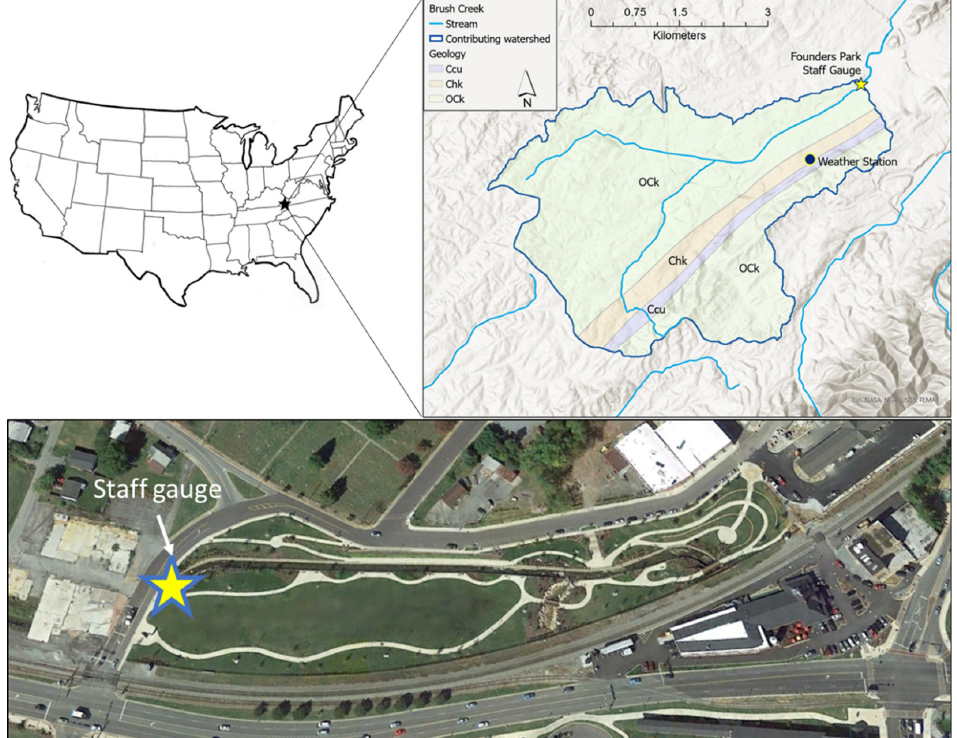
Figure 1. Contributing watershed for Brush Creek Community Science project, with location of ETSU Geosciences weather station, staff gauge, and geology, Johnson City, TN. OCk refers to the Knox Dolomite, Ohk to the Honaker dolomite, and Ccu to the shale-dolomite of the Conasauga